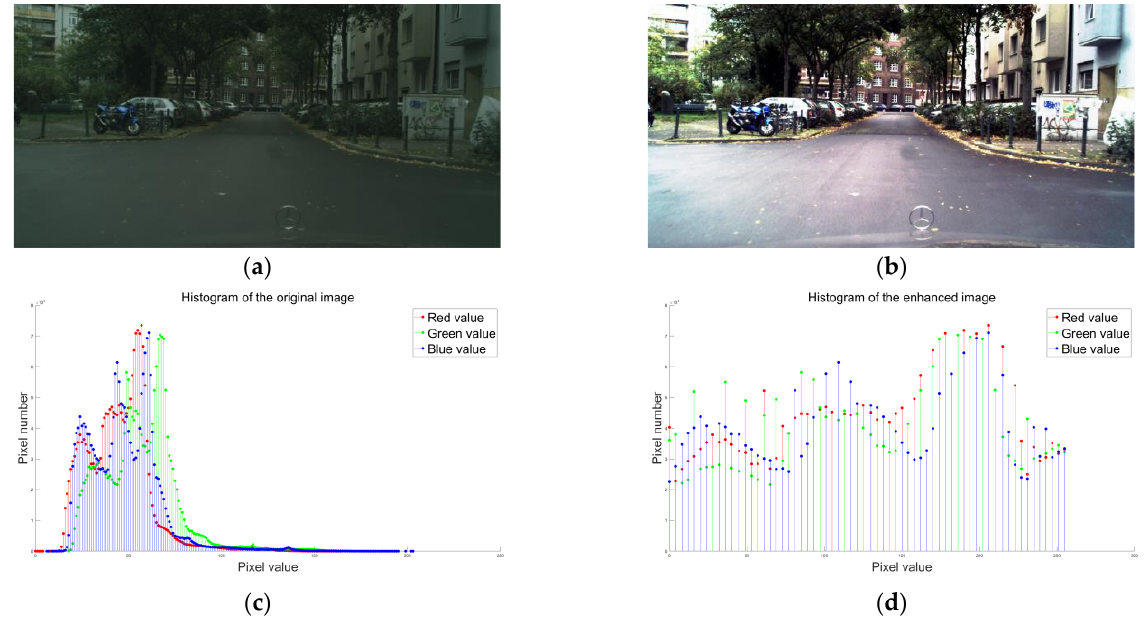
Figure 3. HE enhancement demo: ( a ) Original image. ( b ) HE-enhanced image. ( c ) RGB histogram of the original image. ( d ) RGB histogram of the HE-enhanced image.